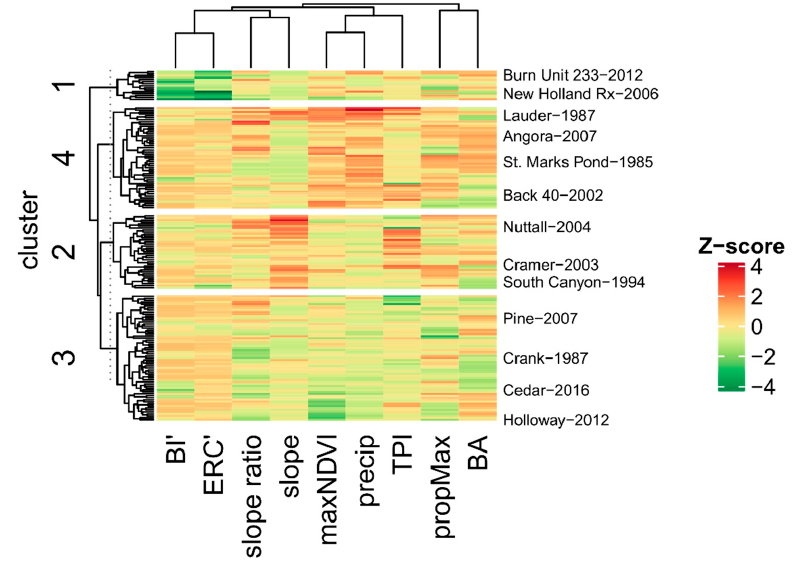
Figure 3. Scaled values (Z-scores) of the nine environmental variables by cluster for each of the 166 firefighter entrapments (1981–2017) used in the analysis. Dendrograms are shown in the margins for the entrapments and environmental variables. Differences in height of the branches in the dendrogram represent differences within and among clusters. Example entrapments (incident name—year of occurrence) for each cluster are also shown in the right margin. See Table 2 for variable definitions. Table 4. Descriptive information for each entrapment cluster along with group comparisons based on